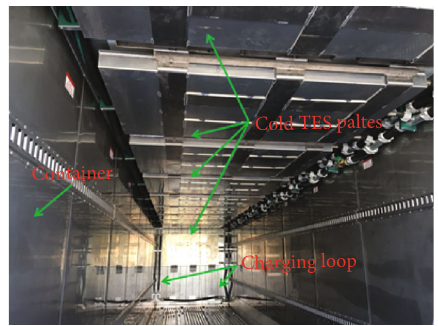
Figure 3: Internal photo of the TES-based